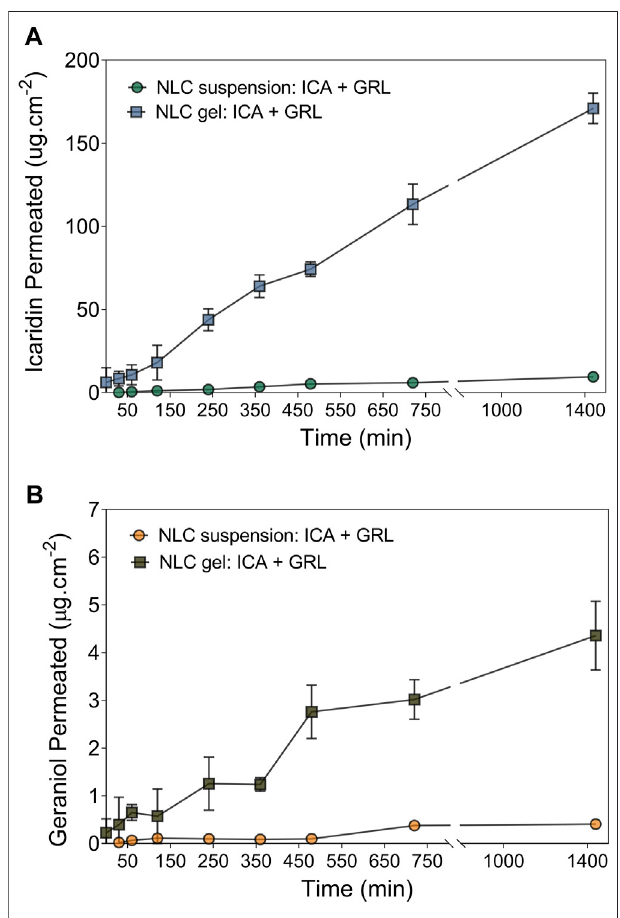
FIGURE 5 | Permeation pro fi les of the repellents across Strat-M ®